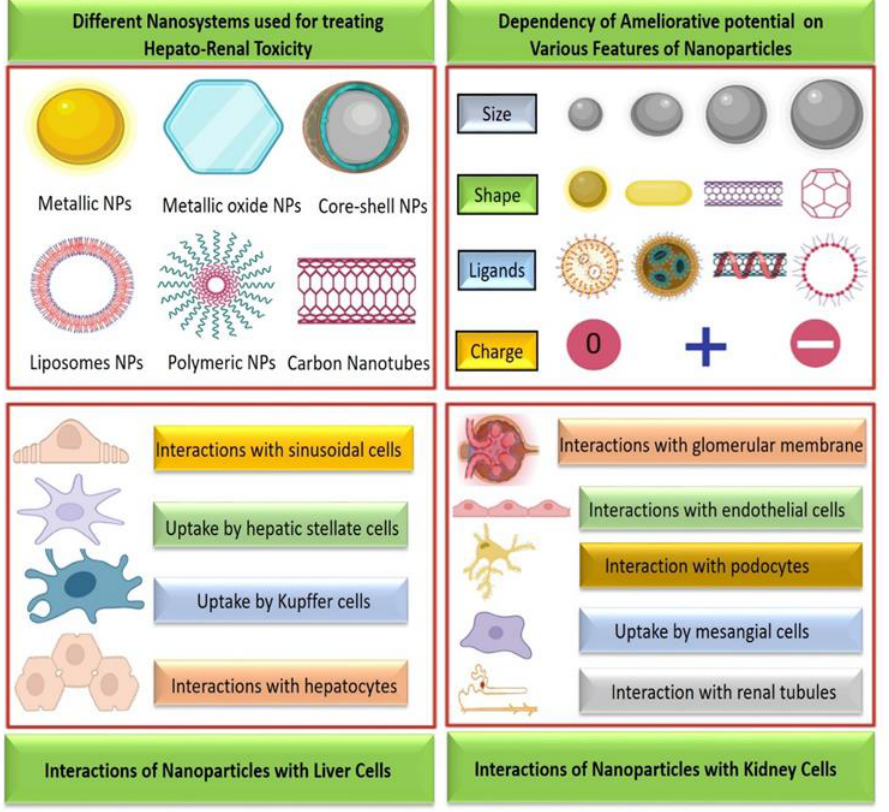
Figure 2. Graphical representation of various nanosystems used for treating hepato-renal toxicity and their interaction with liver and kidney cells .